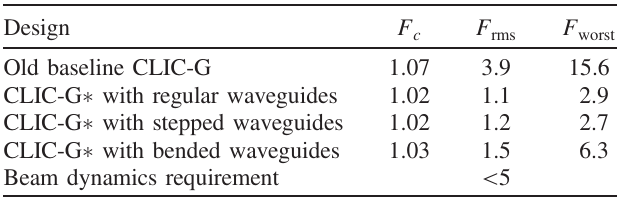
TABLE II. Transverse beam jitter amplification factors in wakefield suppression of all structure